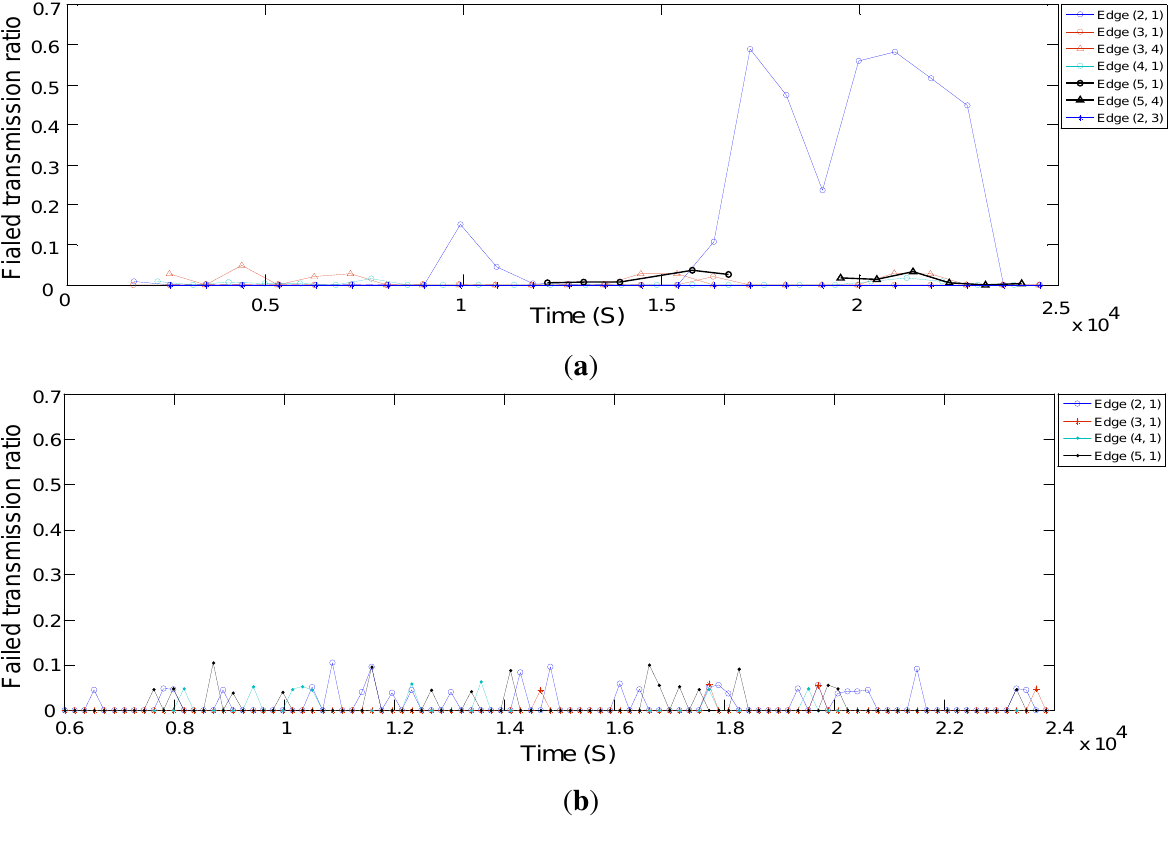
Figure 13. The failed transmission ratio on different edges over time. ( a ) Real network; ( b ) Simulated network with a shadowing deviation of 5.7 dB; and ( c ) Simulated network with a shadowing deviation of 8